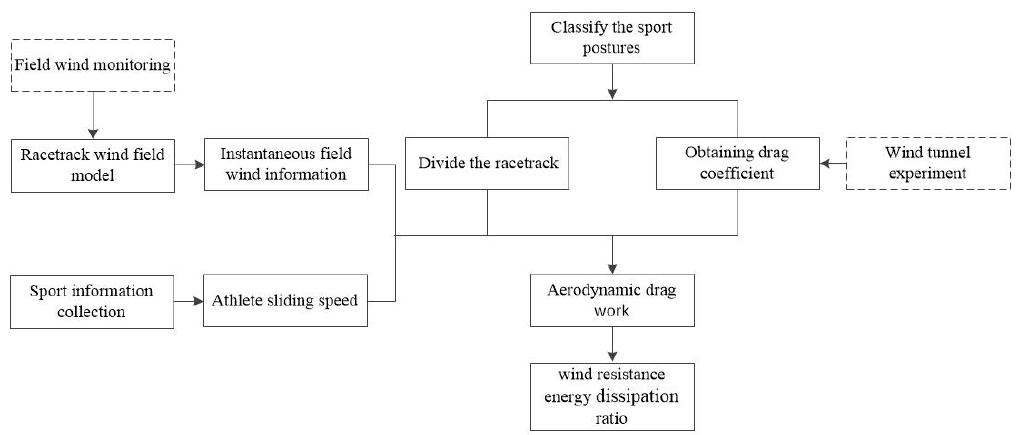
Figure 4. Process of evaluating wind resistance energy